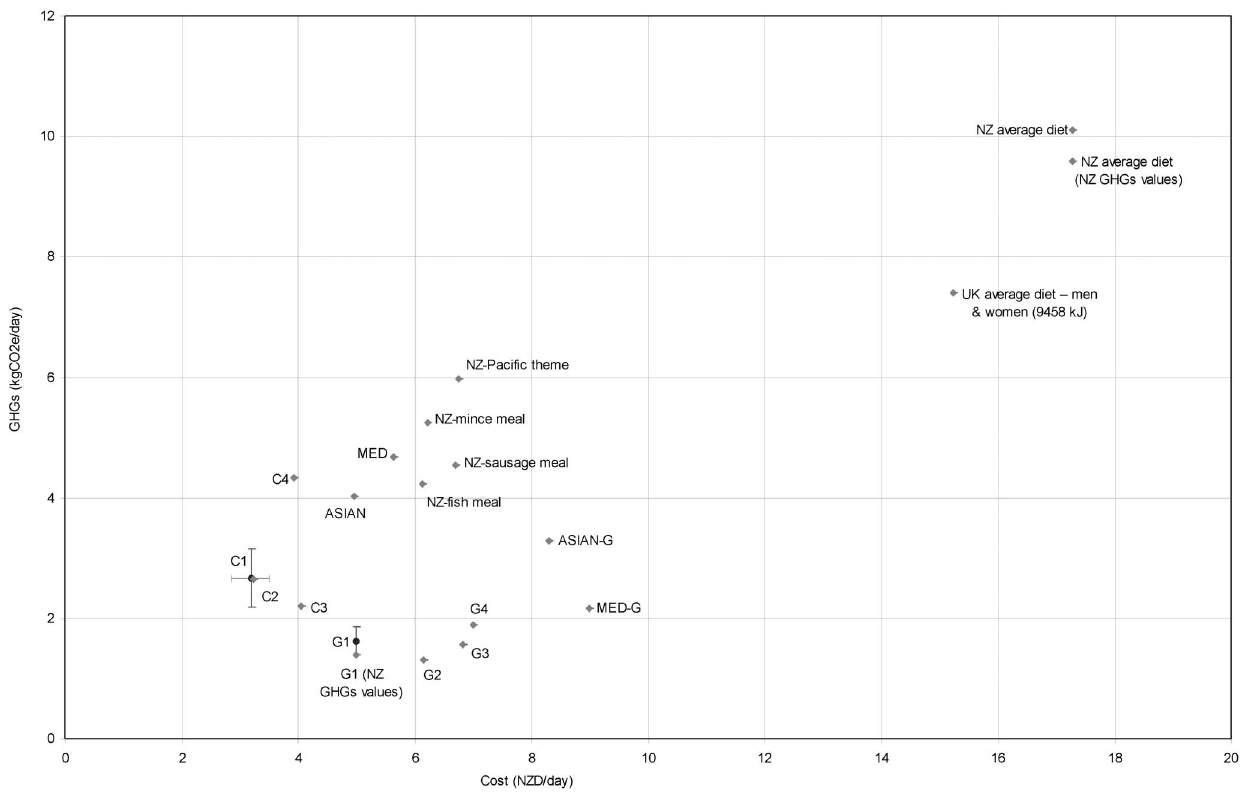
Figure 1. Cost and greenhouse gas (GHG) emissions per day of the various optimized daily dietary scenarios. * *The point estimate for the typical UK diet (at £UK 6.59/d and 7.40 kg CO 2 e/d), came from work by Berners-Lee et al [37], and it is adjusted to NZ$. There are some differences in approach to food wastage by these authors relative to our New Zealand results (i.e. we took a more food-specific approach, albeit also using UK food wastage data). All NZ values are for men consuming 11,450 + kJ and using UK GHGs values for foods unless otherwise indicated. Bars for C1 and G1 indicate 95% simulation intervals (see Table 5).